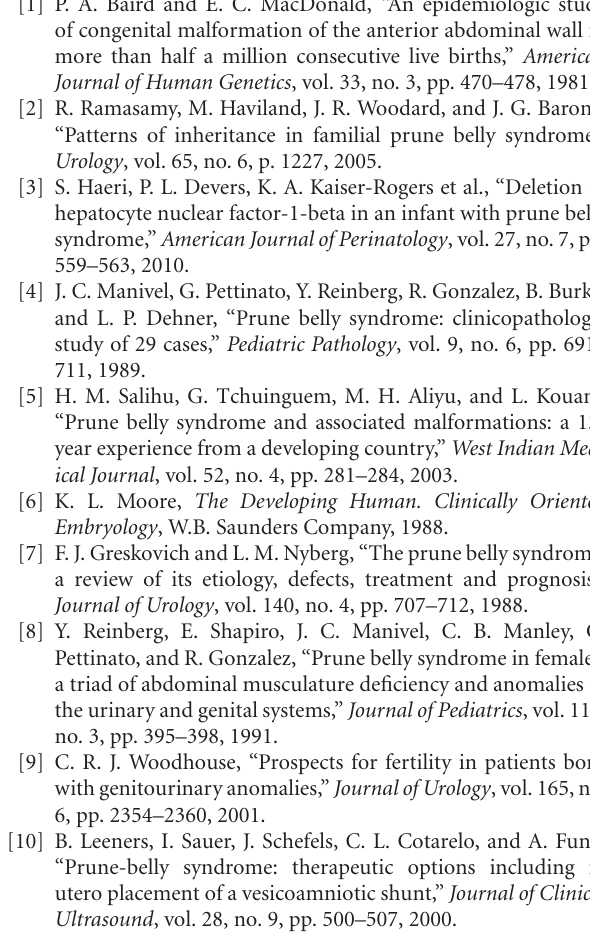
27%, imperforate anus 27%, and arthrogryposis (18%) [4]. In about 75% there are malformations of the cardiopul- monary, gastrointestinal, and orthopaedic systems